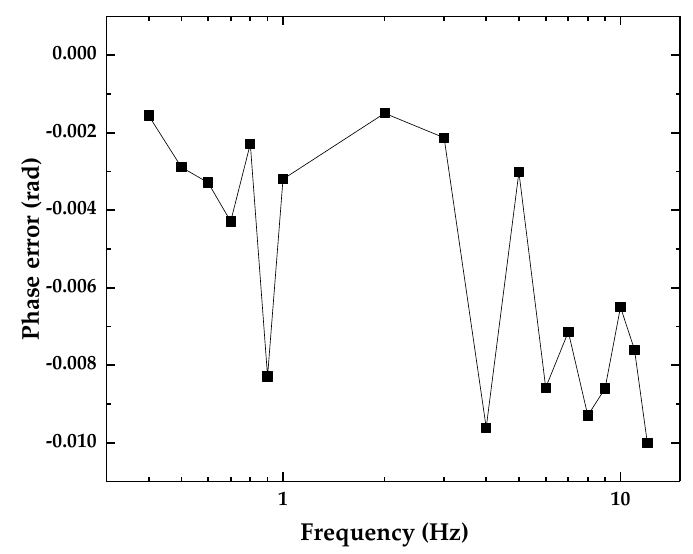
Figure 12. The phase error of the optical accelerometer.